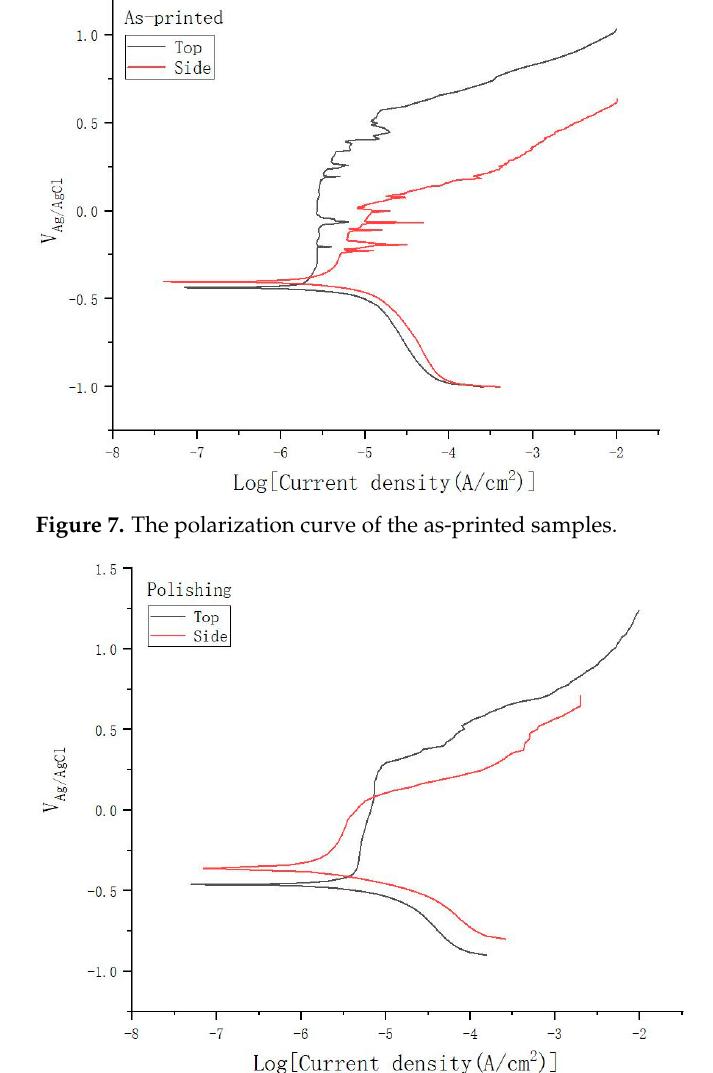
Table 7. The average and standard deviation of 𝐸 (cid:3043) values for samples.